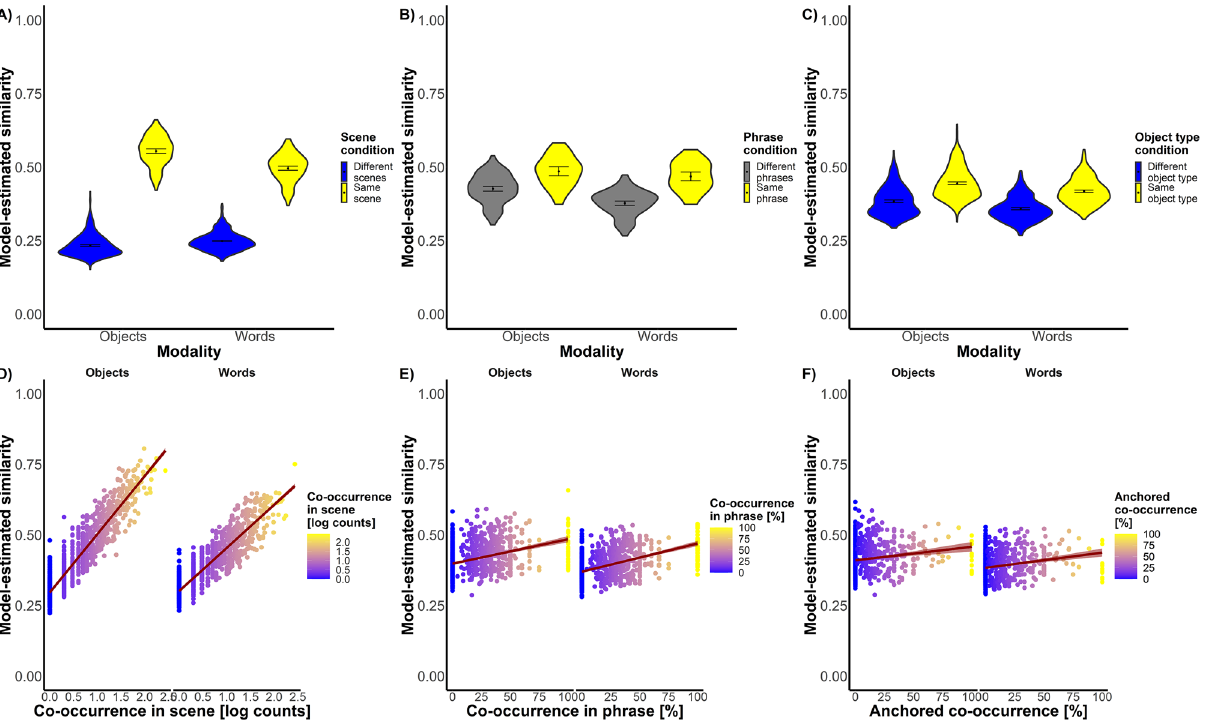
Figure 5. Model-estimated effects of the hierarchy predictors on pairwise similarity ratings for object pictures and words. Colours of violins and points reflect the values of pairs for the given predictor and match the ones in the RDMs showed above. Stimulus modality is indicated by x-axis position (left = objects, right = words). Points and violins reflect estimated similarity for each pair of objects averaged across all the different contexts (i.e., the third object a triplet) in which they were presented. 95% confidence interval are represented by error bars in the violins (point is the mean), and by the shaded area around lines for continuous